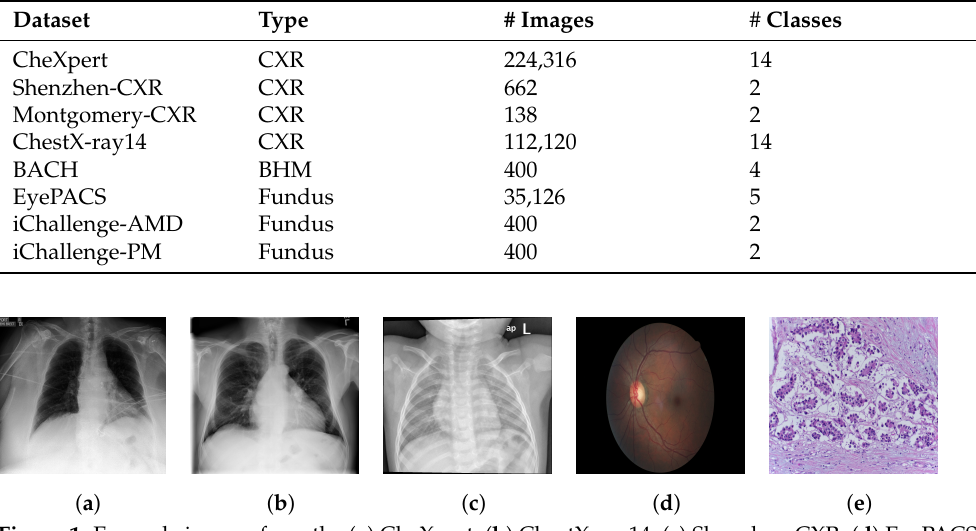
Figure 1. Example images from the ( a ) CheXpert, ( b ) ChestX-ray14, ( c ) Shenzhen-CXR, ( d ) EyePACS, ( e ) BACH datasets. Table 2. Summary of terminology used for datasets and